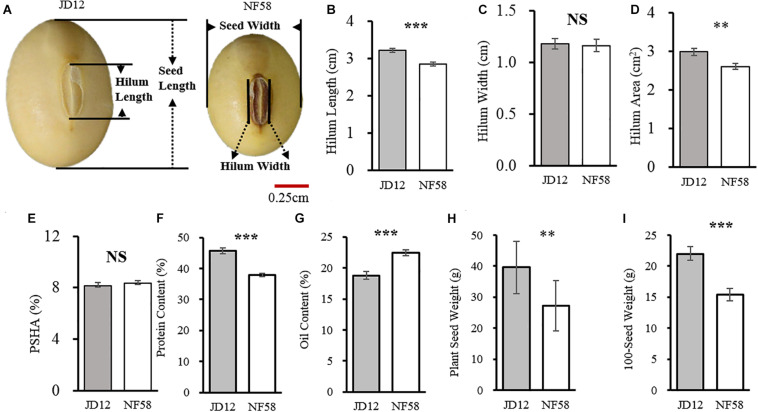
Comparison of hilum traits between soybean parent lines JD12 and NF58. (A) Photos of JD12 and NF58 seeds. (B) Seed hilum length (SHL). (C) Seed hilum width (SHW). (D) Seed hilum area (SHA). (E) Percentage of hilum area in seed projected area (PSHA). (F) Protein content (PC). (G) Oil content (OC). (H) Plant seed weight (PSW). (I) Hundred seed weight (100SW). Bars represent means ± SE from 15 replications. Asterisks indicate significant differences between JD12 and NF58 in the Student’s t test at the *P = 0.05, **P = 0.01, and ***P = 0.001 levels.